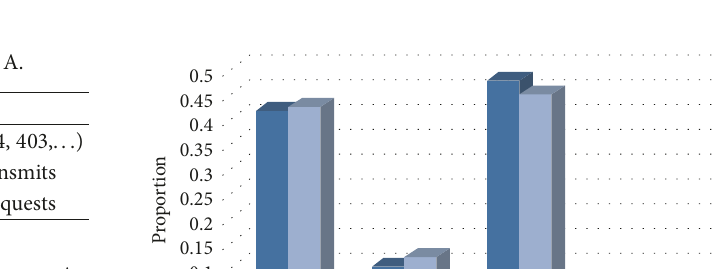
Table 3: Result of model for different performance on data set A.